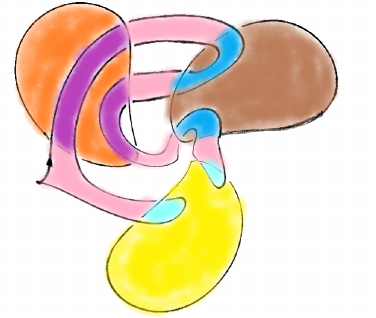
Figure 5. The entanglement structure of an Ω ( 4,3 ) link in the topological